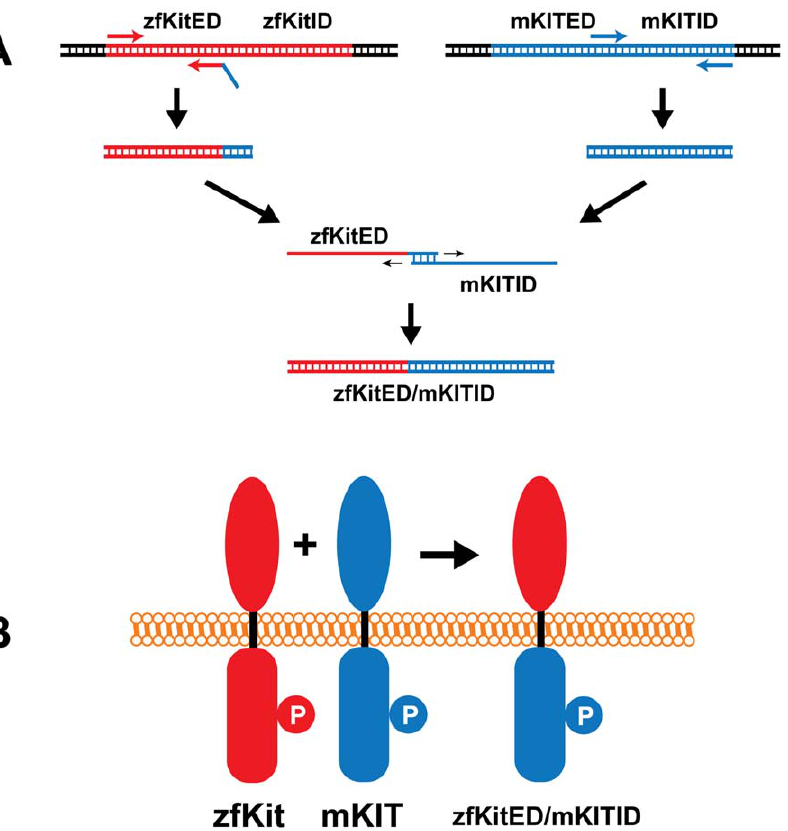
Figure 6. Schematic illustration of plasmid construction for expressing chimeric receptors. The mouse Kit receptor is shown in blue and zebrafish Kita or Kitb is in red. The extracellular domain of zebrafish Kita or Kitb (zfKitED) and intracellular domain of mouse KIT (mKITID) were amplified by PCR followed by extension of the PCR products on each other to generate a DNA fragment (A) coding for the fusion protein zfKitED/ mKITID (B). ‘‘P’’ represents the phosphorylated tyrosine site in the intracellular domain that is recognized by the antibody.